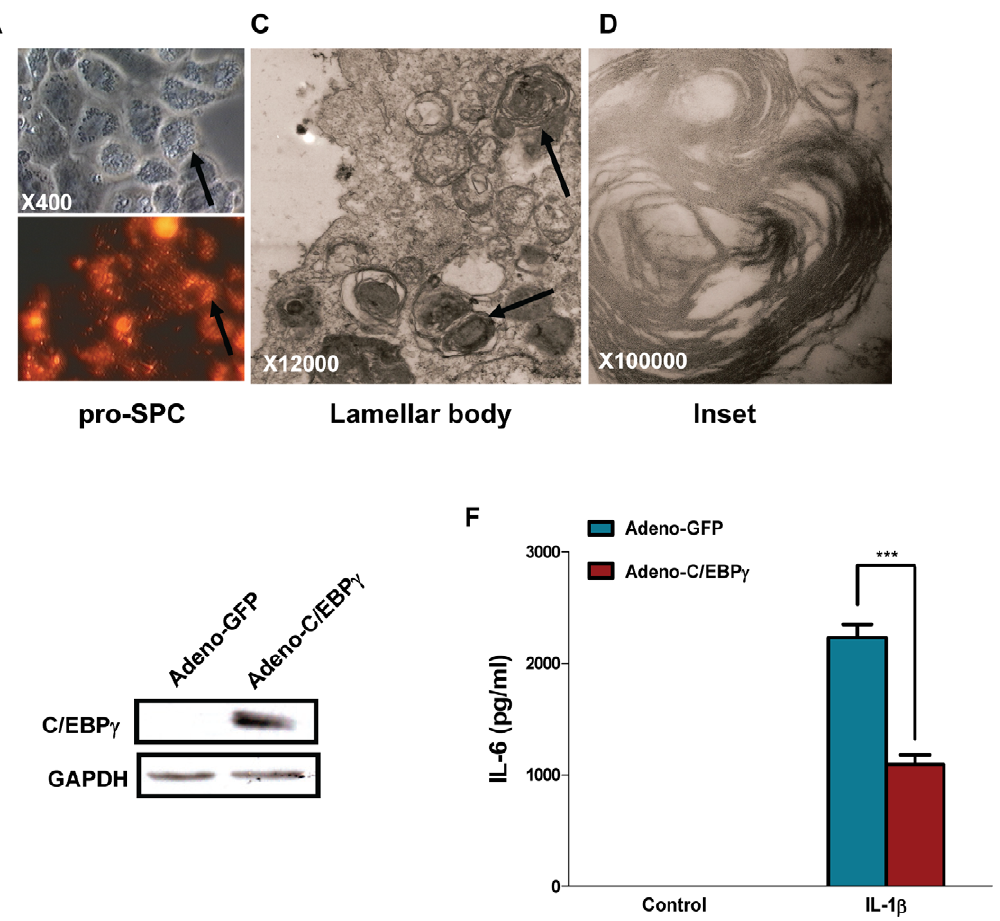
Figure 3. Over-expression of C/EBP c suppresses IL-1 b -induced IL-6 production in primary cultured alveolar type II epithelial cells. A–D, alveolar type II epithelial cells were isolated from C57BL6 mouse, and identified by pro-SP-C immunostaining (A, B), as well as lamellar body transmission electron microscopy. A, B, and C indicate DIC, fluorescence, and transmission electron microscopy, respectively; and D indicates enlarged lamellar body. Arrows in A and B indicate staining for pro-SP-C and in C indicate lamellar body. E, alveolar type II epithelial cells were infected with Adeno-GFP or Adeno-C/EBP c at a MOI of 50. 24 h after infection, the total protein were harvested and subjected for Western blot by using antibodies against C/EBP c and GAPDH, respectively. F, alveolar type II epithelial cells were infected with Adeno-GFP or Adeno-C/EBP c at a